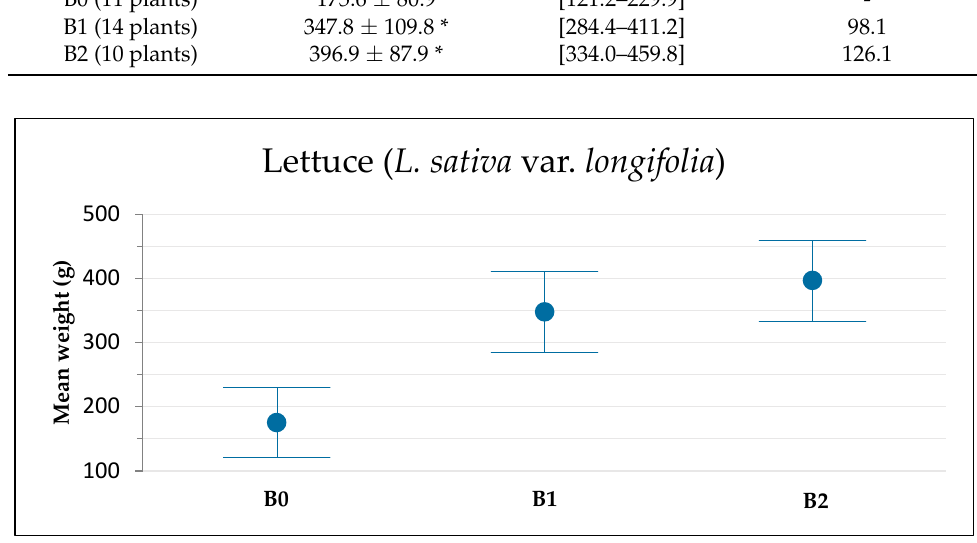
Figure 4. Mean lettuce weight and confidence interval of each treatment ( α = 0.05).